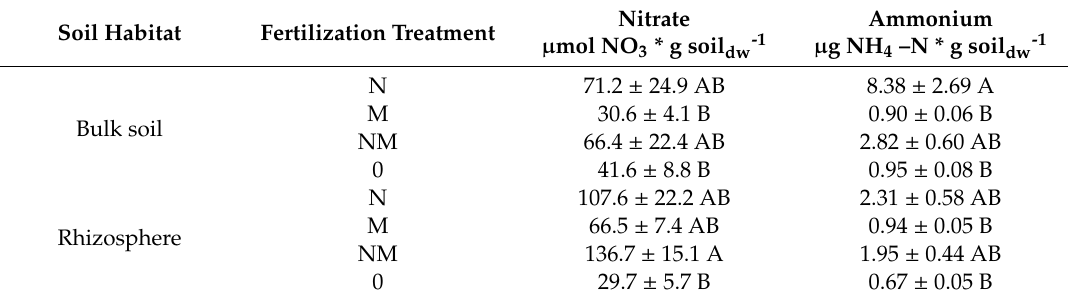
Table 4. Concentrations of nitrate and ammonium in the two soil habitats, under the four N-fertilization